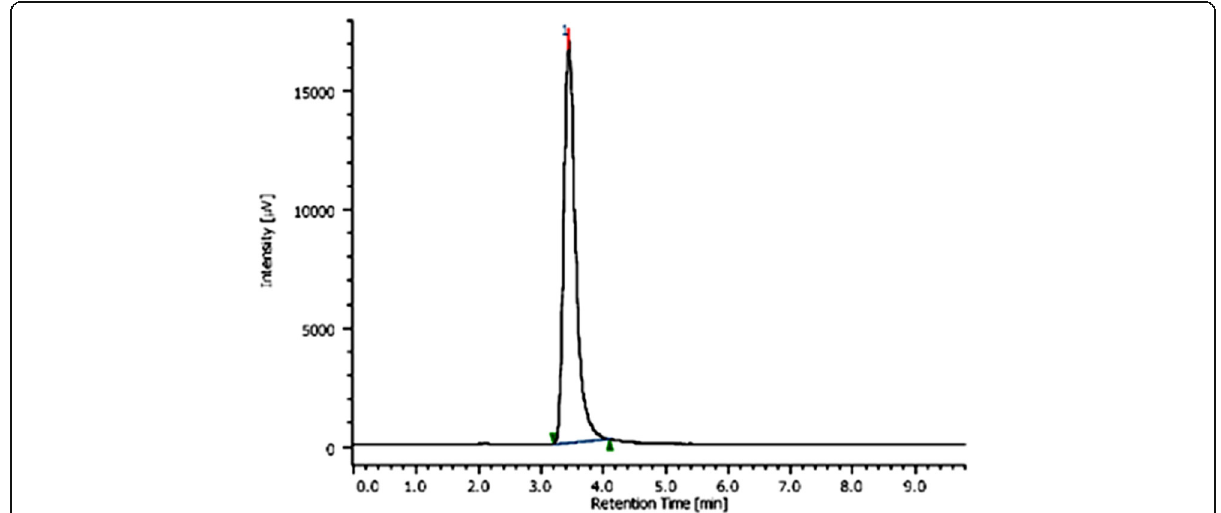
Fig. 2 Standard chromatogram of Efonidipine